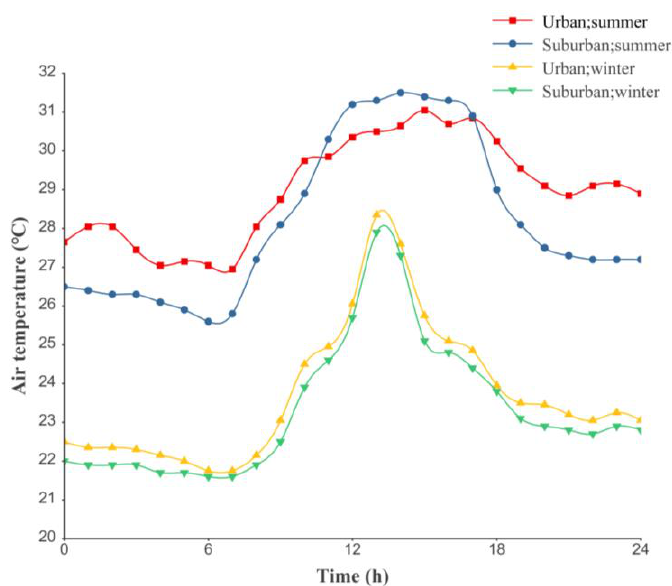
Figure 5. Air temperature changes in typical urban and suburban areas.